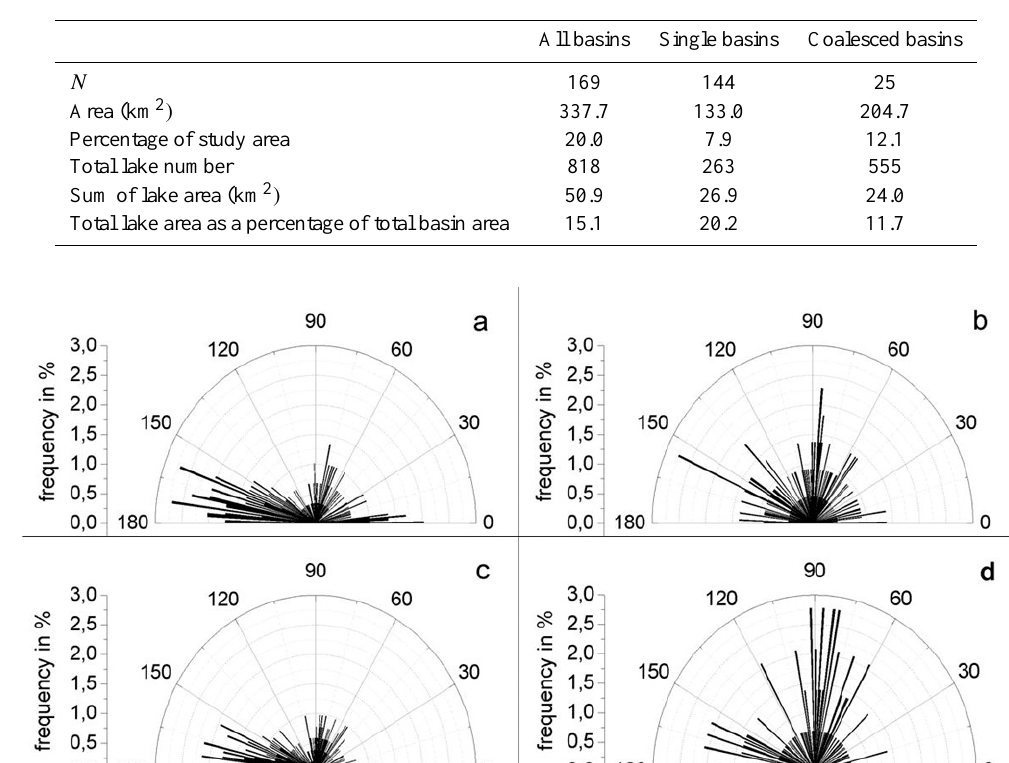
Table 3. Area calculations for thermokarst basins on the third Lena Delta terrace (except bedrock islands).